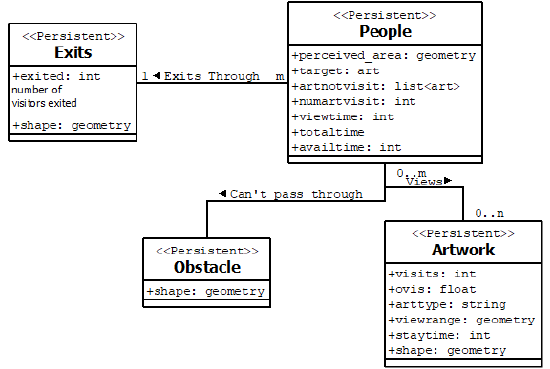
Figure 7. Class Diagram of the agents in the environment